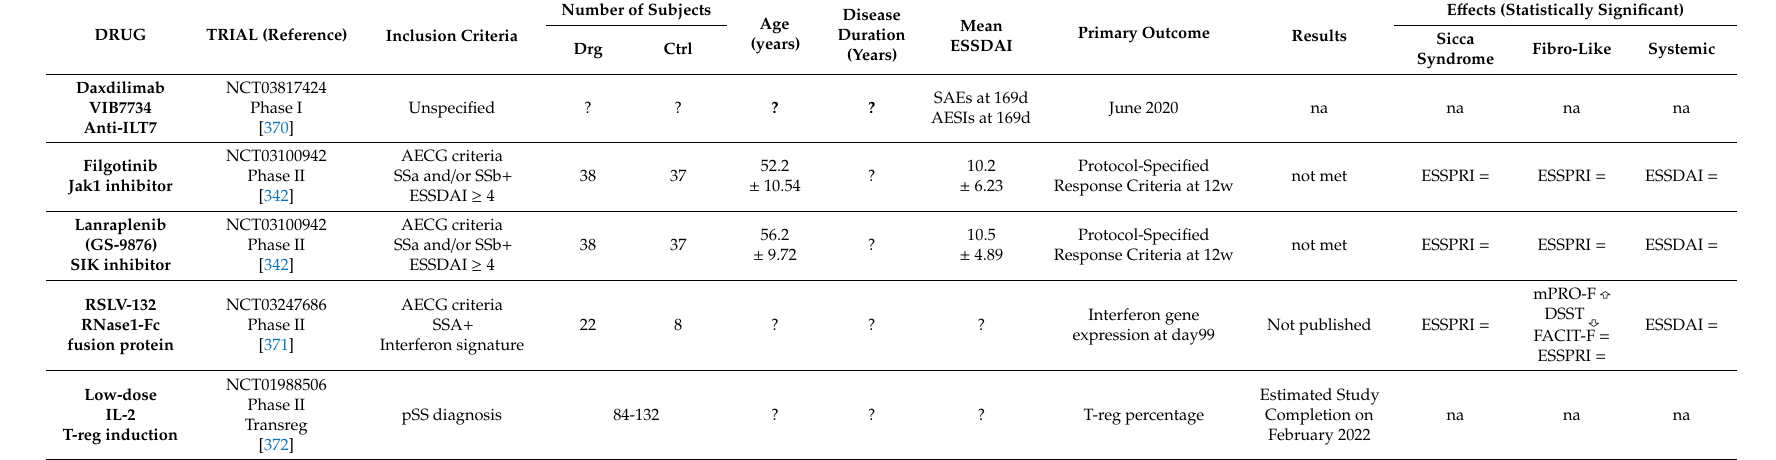
Table 12. Miscellaneous targeted drugs in